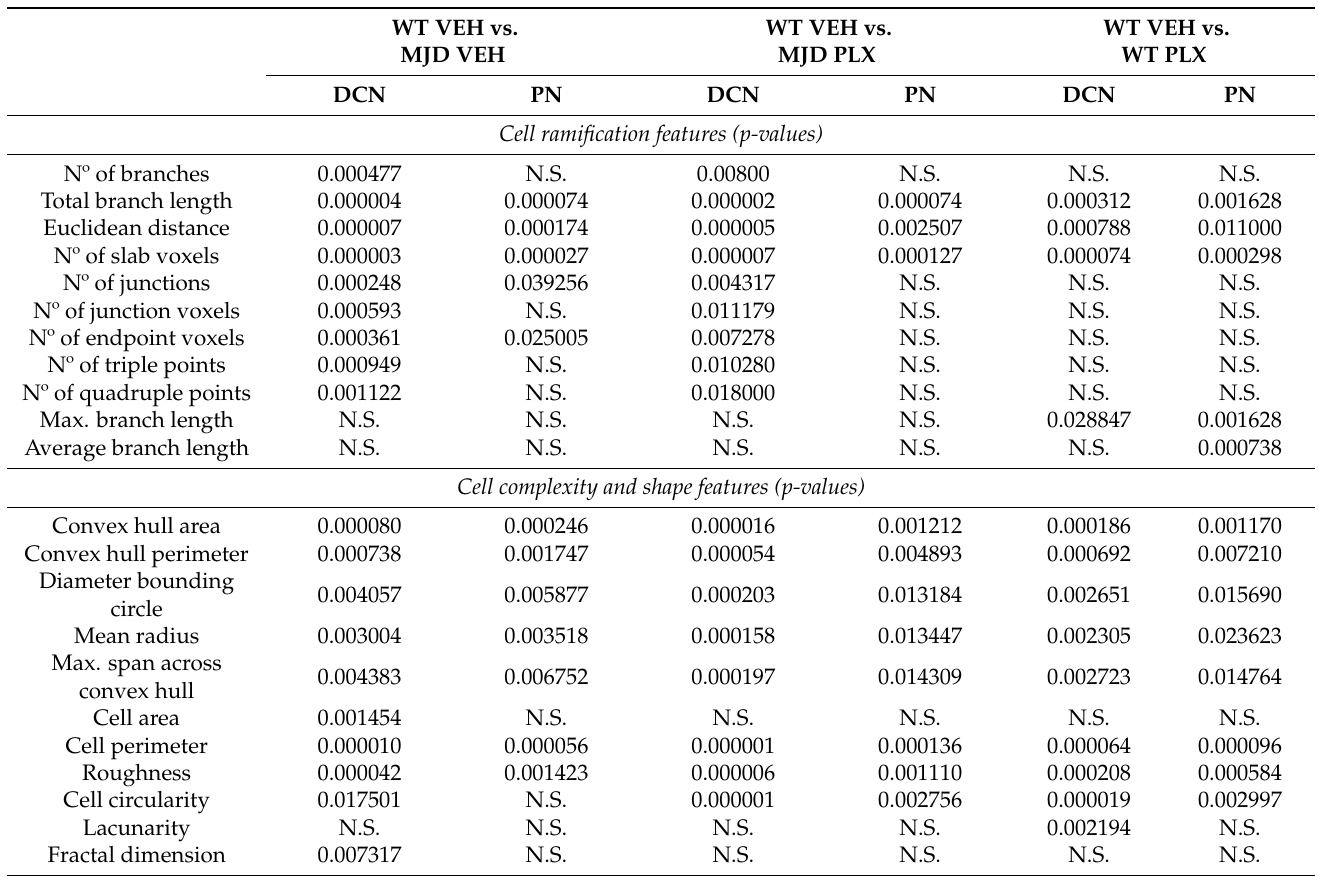
Table 1. Significant morphological changes found in both brain regions, DCN and PN, in features relevant to cell ramification, size, surface, and soma thickness. “WT VEH” stands for WT + vehicle mice; “MJD VEH” for CMVMJD135 + vehicle mice; “MJD PLX” for CMVMJD135 + PLX3397 mice; and “WT PLX” for WT + PLX3397 mice. A significance level of p < 0.05 was used. N.S. stands for non-significant values. WT VEH vs. WT VEH vs. WT VEH vs. MJD VEH MJD PLX WT PLX DCN PN DCN PN DCN PN Cell ramification features